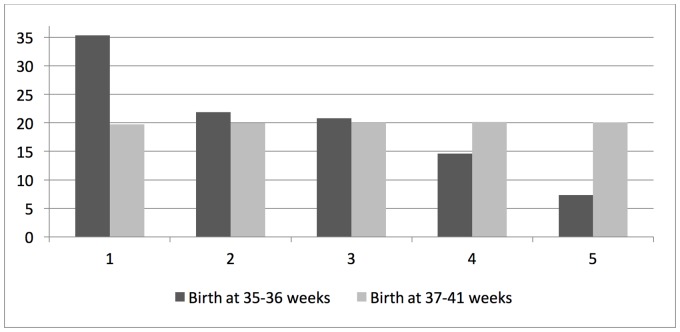
Rates (%) of TREC values in quintiles (1 = lowest quintile) after preterm birth (35–36 weeks) and term birth (37–41 weeks), respectively.(Chi-square p-value<0.001).